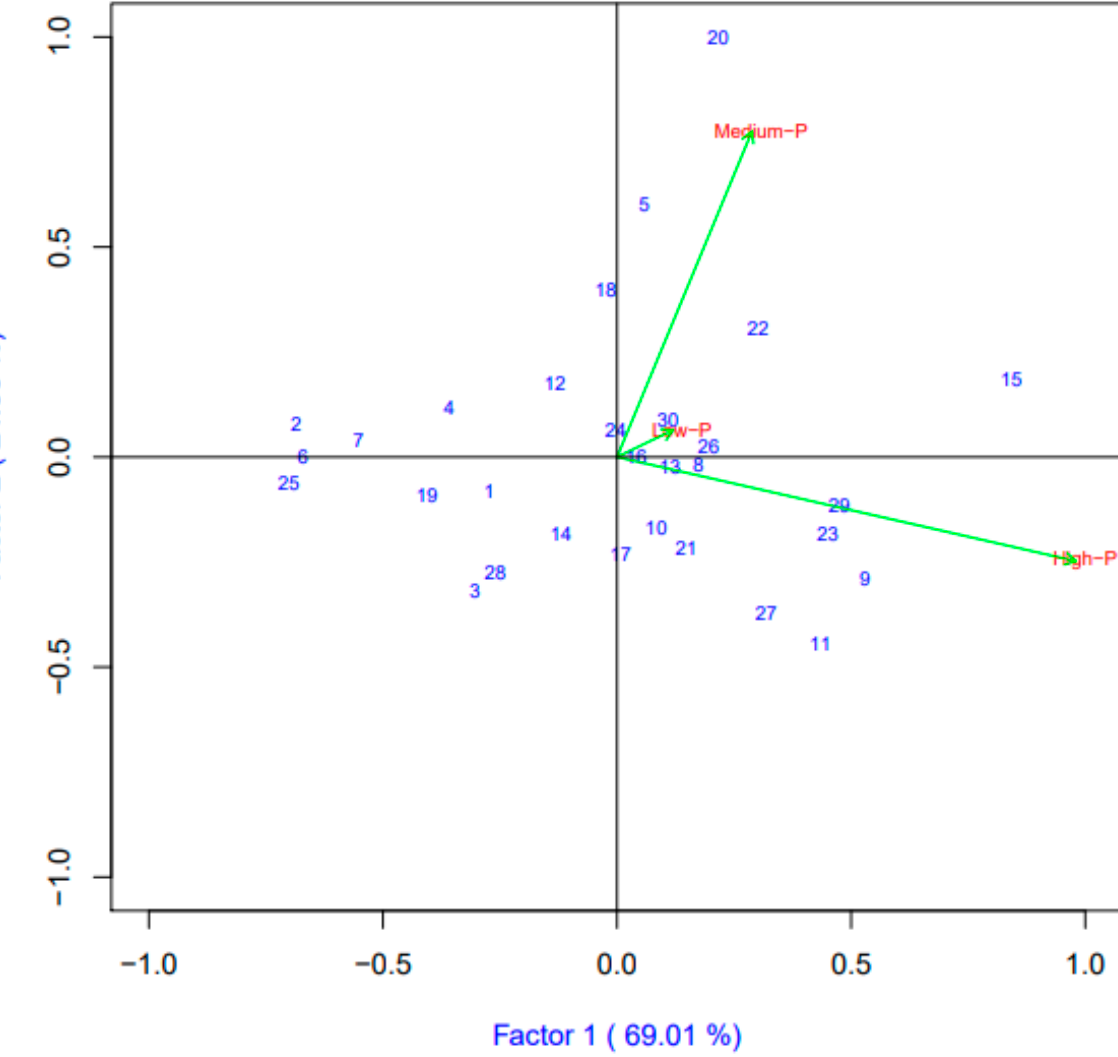
Figure 6. Genotype main effect plus Genotype by Environment (GGE) biplot showing the grain yield of the genotypes at varying soil P levels. Factors 1 and 2 are the principal component axis. Low-P = no P application of P 2 O 5 , Med-P = 10 kg